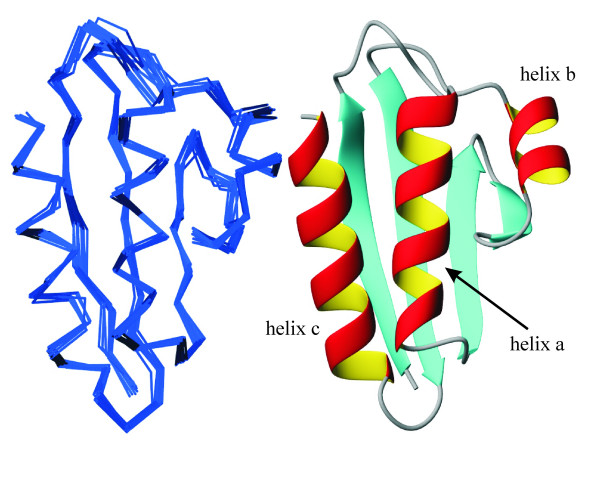
Homology structures of HPr from E. coli determined by PERMOL. Ensemble of the 10 homology structures with the lowest pseudo-energy out of 200 structures calculated with DYANA. (left) A superimposition of the Cα atom traces is shown. (right) A cartoon representation of the mean structure of the 10 models is displayed.